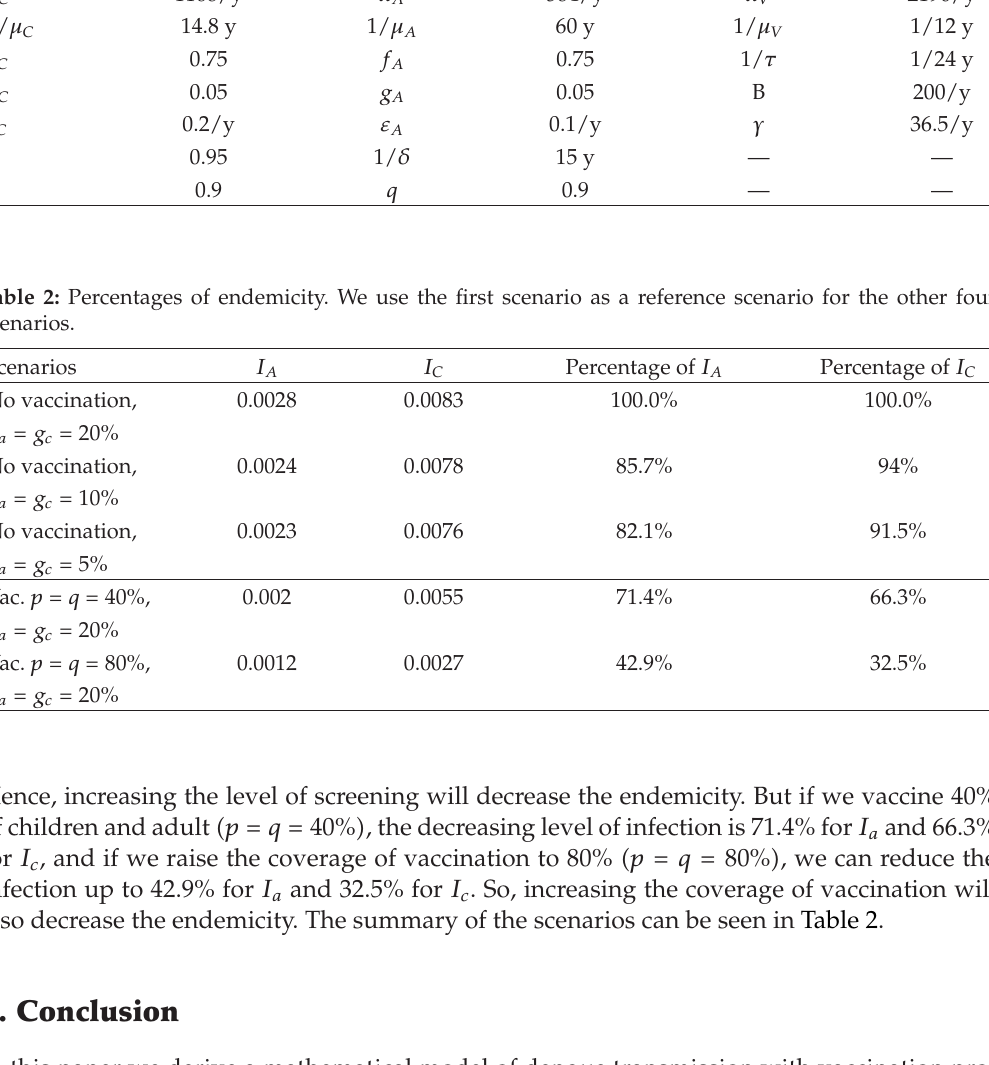
Table 1: Data for numerical simulations (cid:5) y represents years (cid:6) . Par.